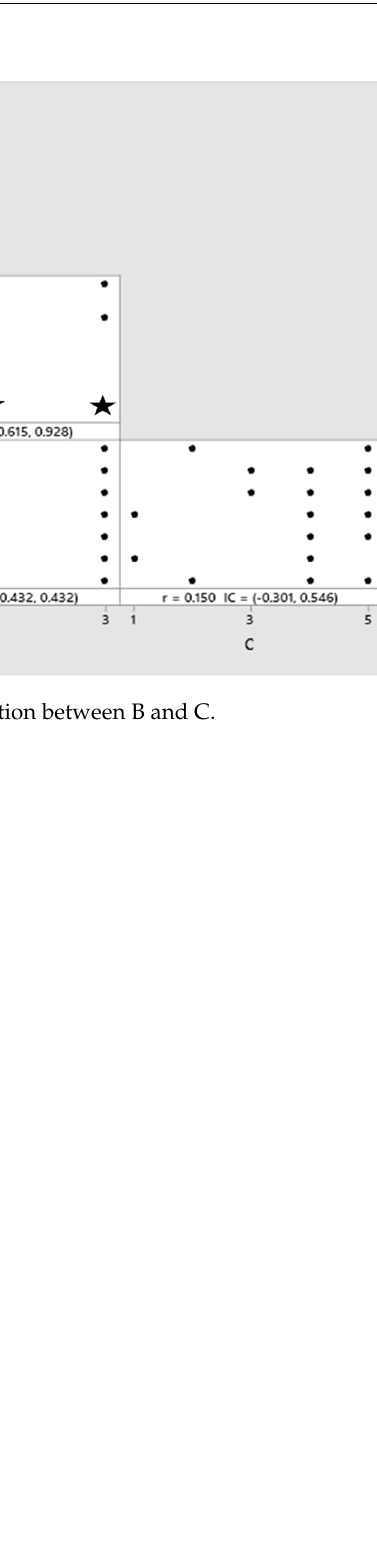
Figure 11. EA (24, 3 2 5 1 7 1 ) with additional signs for B and C.